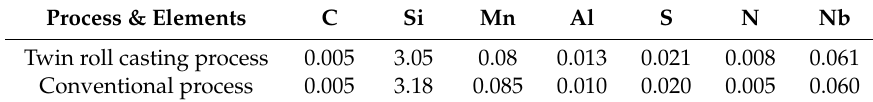
Table 1. Chemical composition of experimental steels.